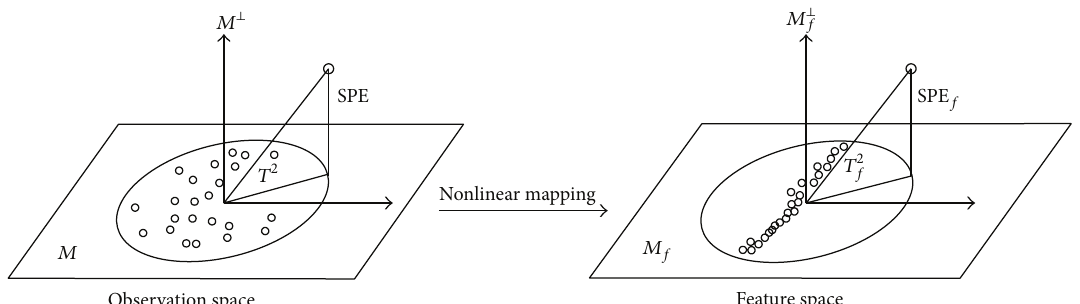
Figure 2: The principle of KPCA-based structure health monitoring